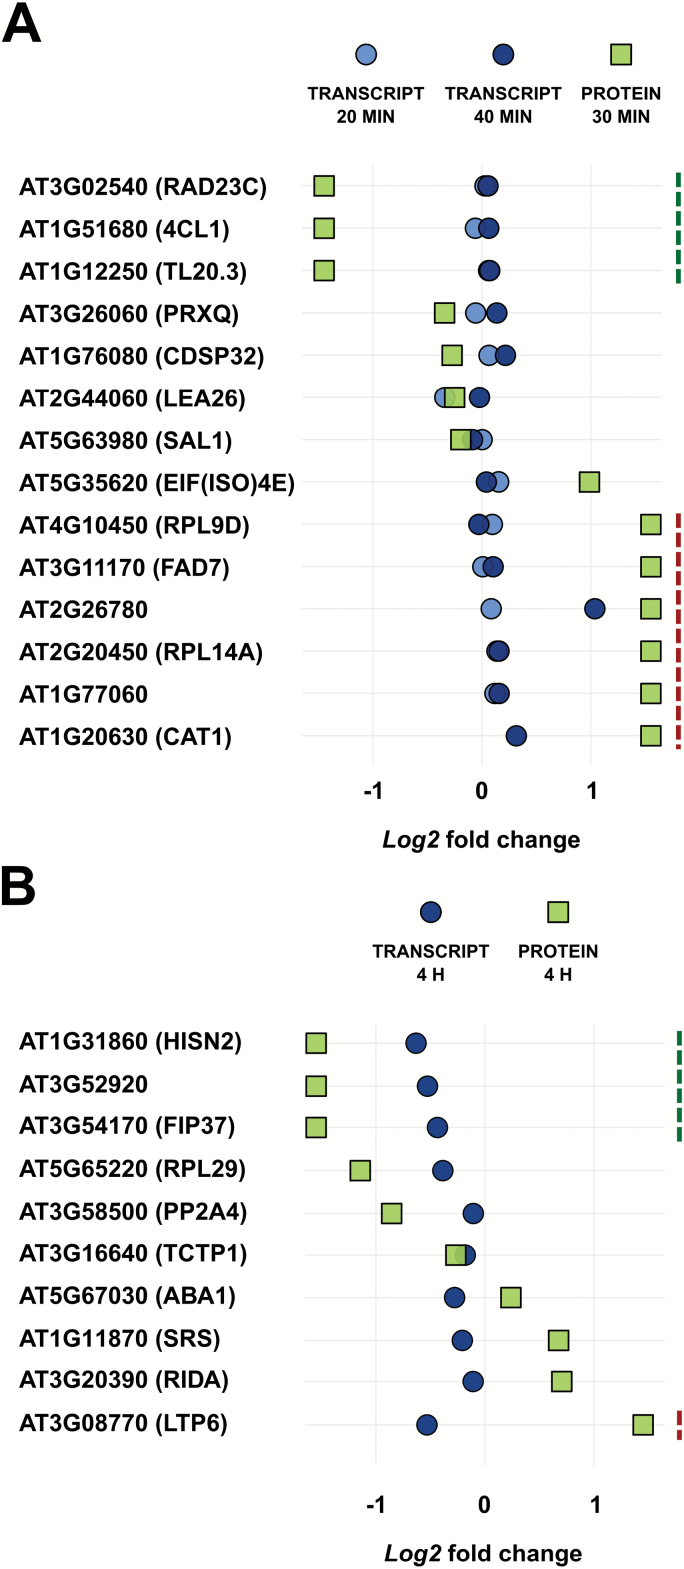
Comparison of protein abundance with the transcript level of the corresponding genes. The differential expression of genes encoding significant differentially up- or down-regulated proteins at (A) 30 min or (B) 4 h after mannitol treatment was analysed at (A) 20 min or 40 min and (B) 4 h after mannitol treatment. The expression and protein levels were measured in expanding leaf tissue upon mannitol treatment and compared with control conditions. Dashed lines indicate proteins unique for control (green) or mannitol-treated (red) samples. RAD23C, RADIATION SENSITIVE23C; 4CL1, 4-COUMARATE:COA LIGASE 1; TL20.3, THYLAKOID LUMENAL PROTEIN TL20.3; PRXQ, PEROXIREDOXIN Q; CDSP32, CHLOROPLASTIC DROUGHT-INDUCED STRESS PROTEIN OF 32 kDa; LEA26, LATE EMBRYOGENESIS ABUNDANT 26; SAL1, SAL1 phosphatase; EIF(ISO)4E, EUKARYOTIC TRANSLATION INITIATION FACTOR ISOFORM 4E; RPL9D, 60S RIBOSOMAL PROTEIN L9-2; FAD7, FATTY ACID DESATURASE 7; RPL14A, 60S RIBOSOMAL PROTEIN L14-1; CAT1, CATALASE 1; HISN2, HISTIDINE BIOSYNTHESIS 2; FIP37, FKBP12-INTERACTING PROTEIN OF 37 kDa; RPL29, 50S RIBOSOMAL PROTEIN L29; PP2A4, PROTEIN PHOSPHATASE 2A ISOFORM 4; TCTP1, TRANSLATIONALLY-CONTROLLED TUMOR PROTEIN 1; ABA1, ABA DEFICIENT 1; SRS, SERYL-tRNA SYNTHETASE; RIDA, REACTIVE INTERMEDIATE DEAMINASE A; LTP6, NON-SPECIFIC LIPID-TRANSFER PROTEIN 6.